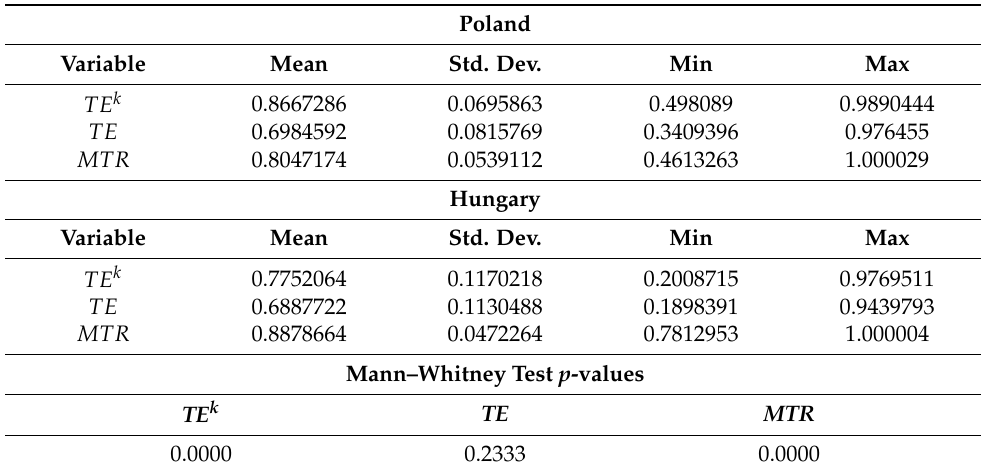
Table A2. Technical efficiency, metafrontier and metatechnology ratio for the Battese and Coelli (1992)